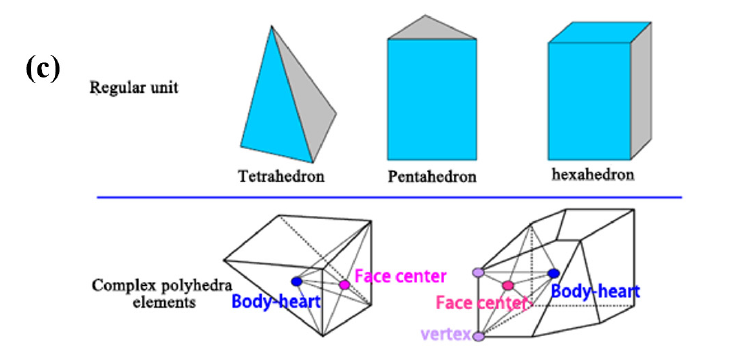
Figure 21. Schematic diagram of CDEM method and principle. ( a ) The structure of the numerical model in CDEM. ( b ) Node type in CDEM. ( c ) The element of finite element in CDEM. CDEM can monitor the contact force, the type of microcracks and the number of mi ‐ crocracks at various points within the specimen during the test, while the development of cracks on the surface of the specimen and the displacement of the specimen as a whole can be observed on a macroscopic level. In CDEM, when the particles are subjected to an external load, the particles move and change the bonding force between them. When the bonding force exceeds the bonding strength of the particles, microscopic cracks are cre ‐ ated, and adjacent cracks overlap to form macroscopic visible cracks.